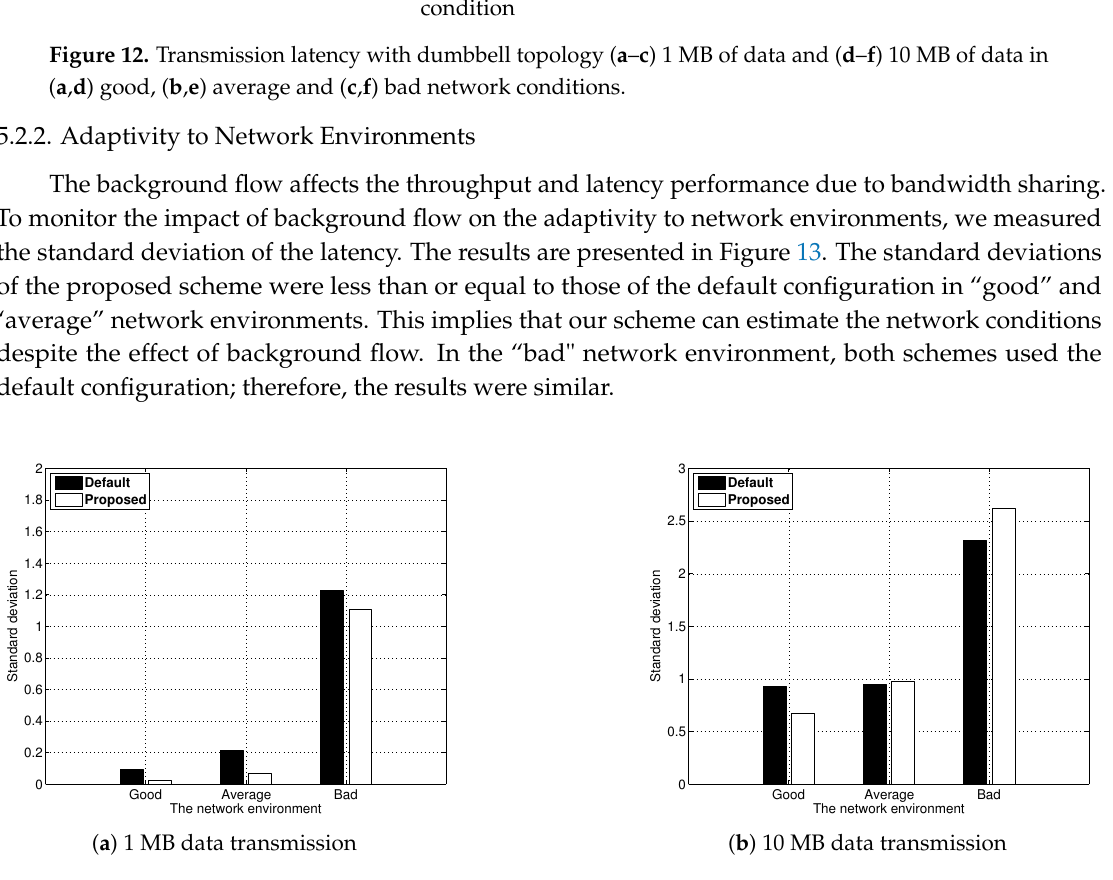
Figure 13. Latency standard deviation values for different network conditions with dumbbell topology. ( a ) 1 MB and ( b ) 10 MB data